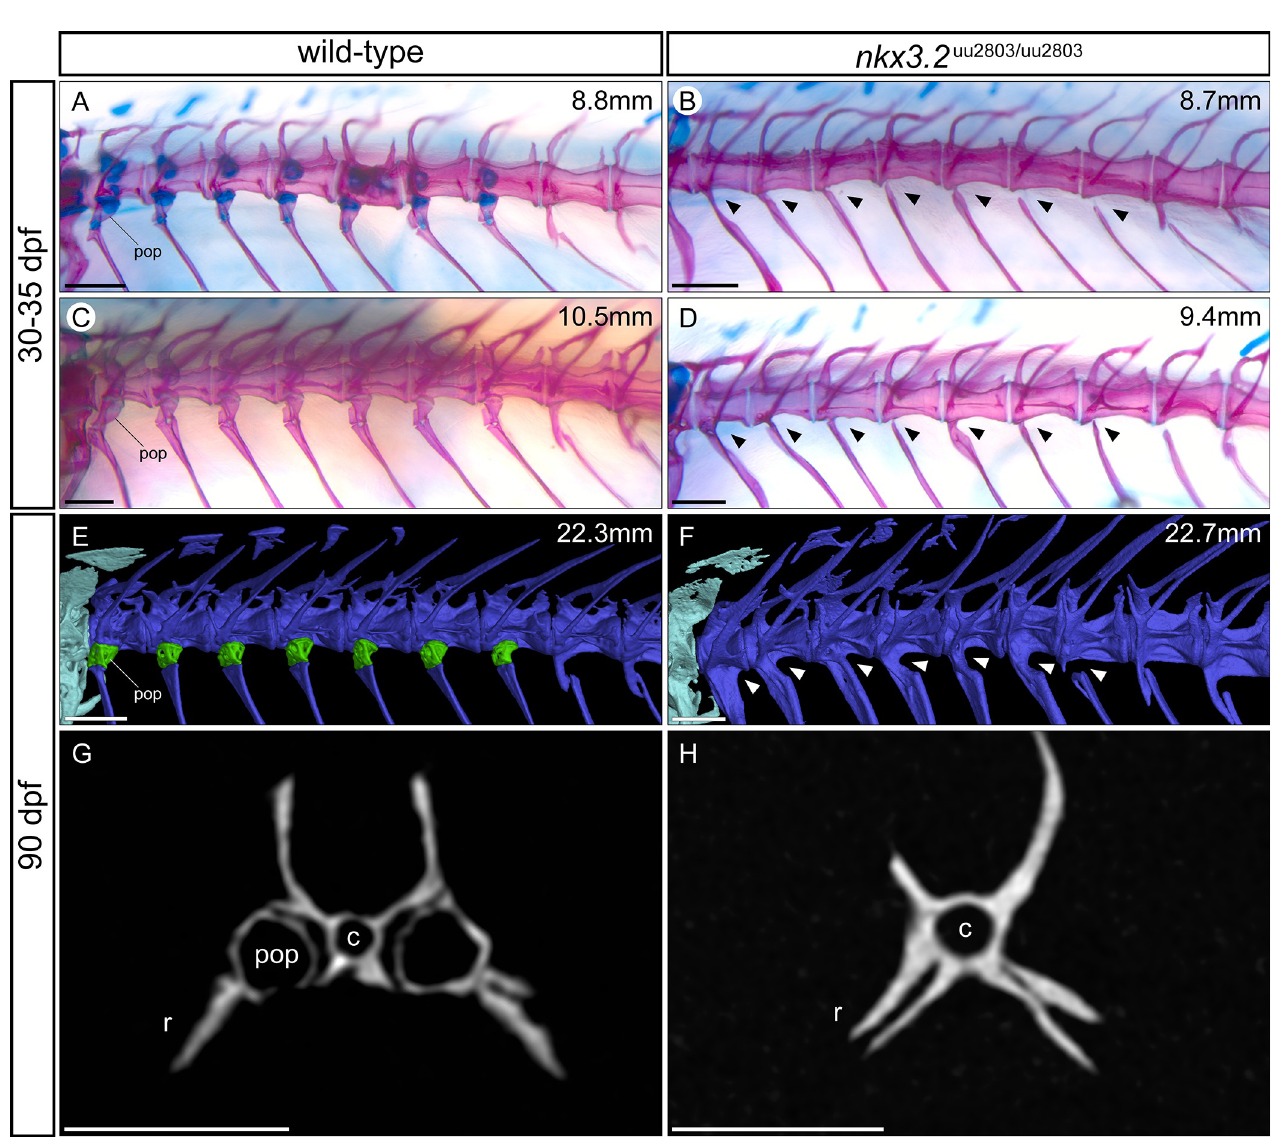
Fig 7. Parapophyses are absent in the rib-bearing vertebrae of nkx3 . 2 uu2803/uu2803 zebrafish. ( A-F ) Dorsolateral views of rib-bearing vertebrae in 30–35 dpf, and 90 dpf wild-type and nkx3 . 2 mutant zebrafish. ( A-D ) Cartilage- and bone- stained juvenile zebrafish, ( E, F ) μ CT models. ( G, H ) μ CT virtual transverse cross-sections of wild-type and nkx3 . 2 mutant rib-bearing vertebrae at 90 dpf. The measurements in mm refer to standard length (SL). Arrowheads in ( B, D, F ) indicate the absence of parapophyses on the rib-bearing vertebrae. Parapophyses (pop) are highlighted in green in ( E ). c–centrum, r–rib. Scale bars: 200 μ m ( A-D ), 500 μ m ( E-H